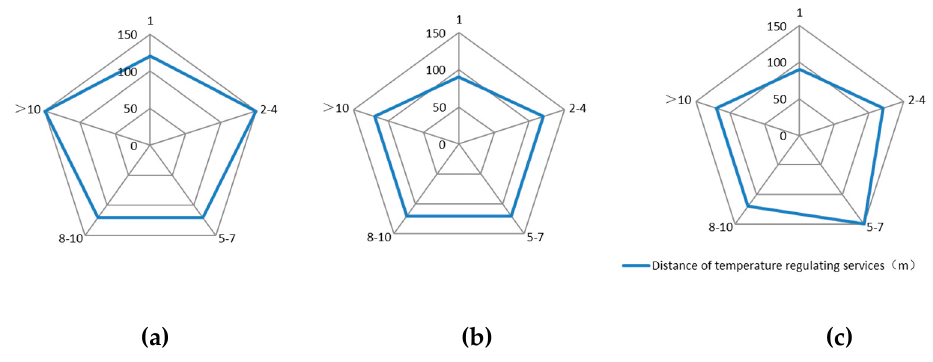
Figure 5. Radar diagram of the supply distance of the “source” landscape for temperature regulating service in ( a ) 2005, ( b ) 2010, and ( c ) 2013 under different shape indexes.